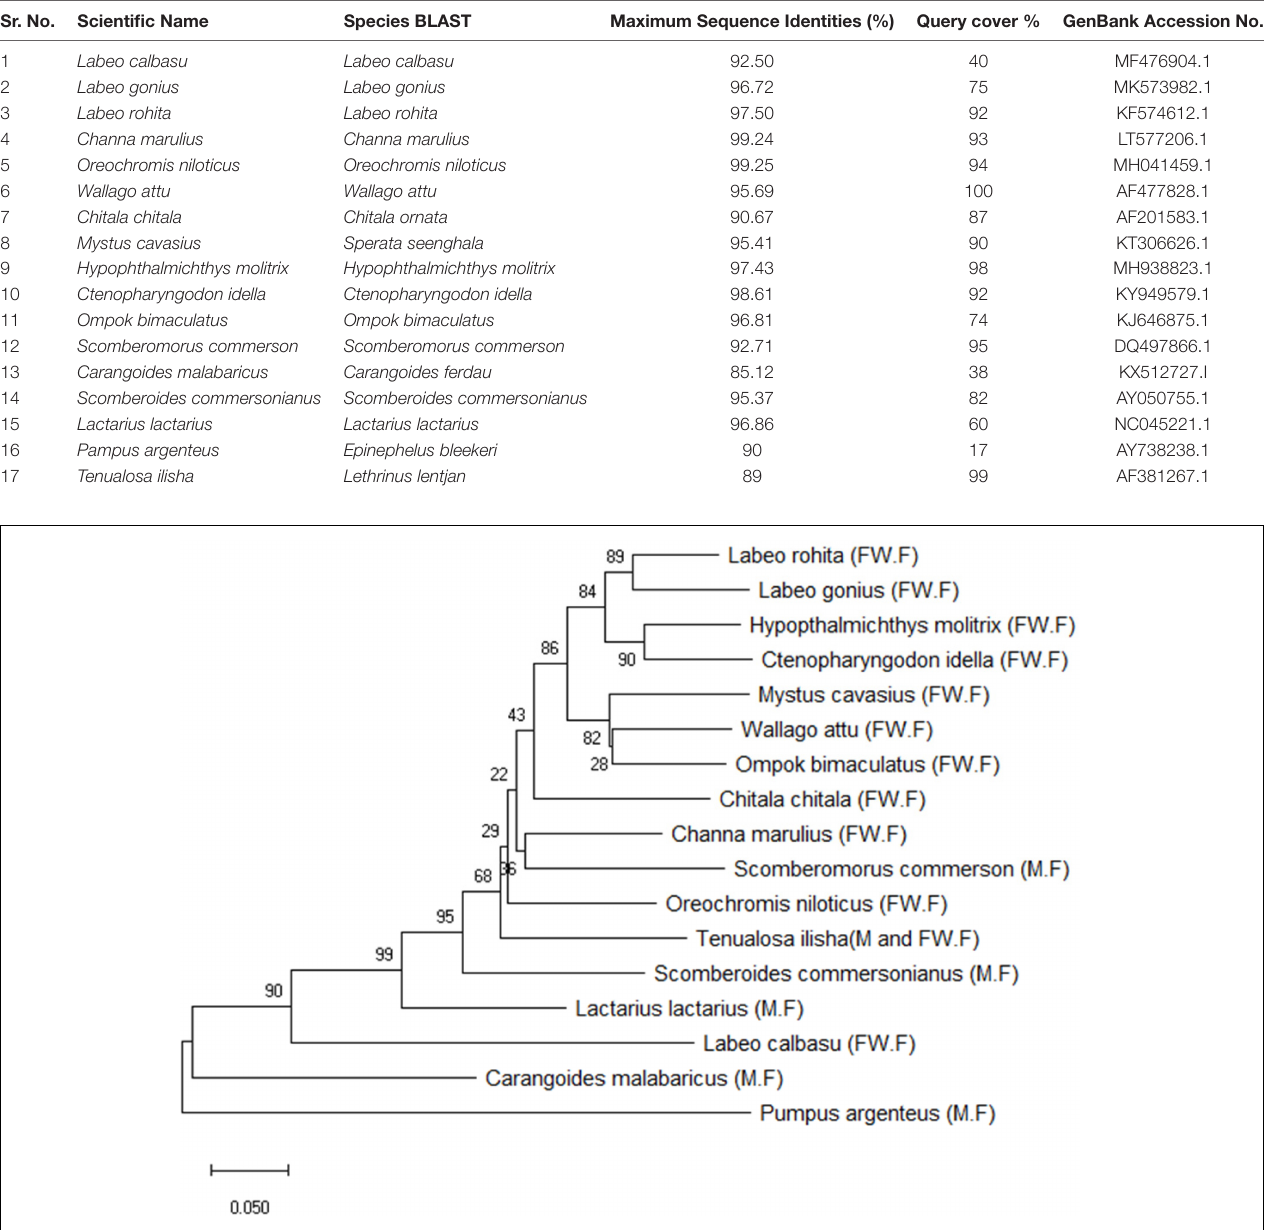
FIGURE 4 | Phylogenetic analysis of freshwater and marine fish species based on the Cyt b gene. (FW.F = freshwater fish, M.F = marine fish).